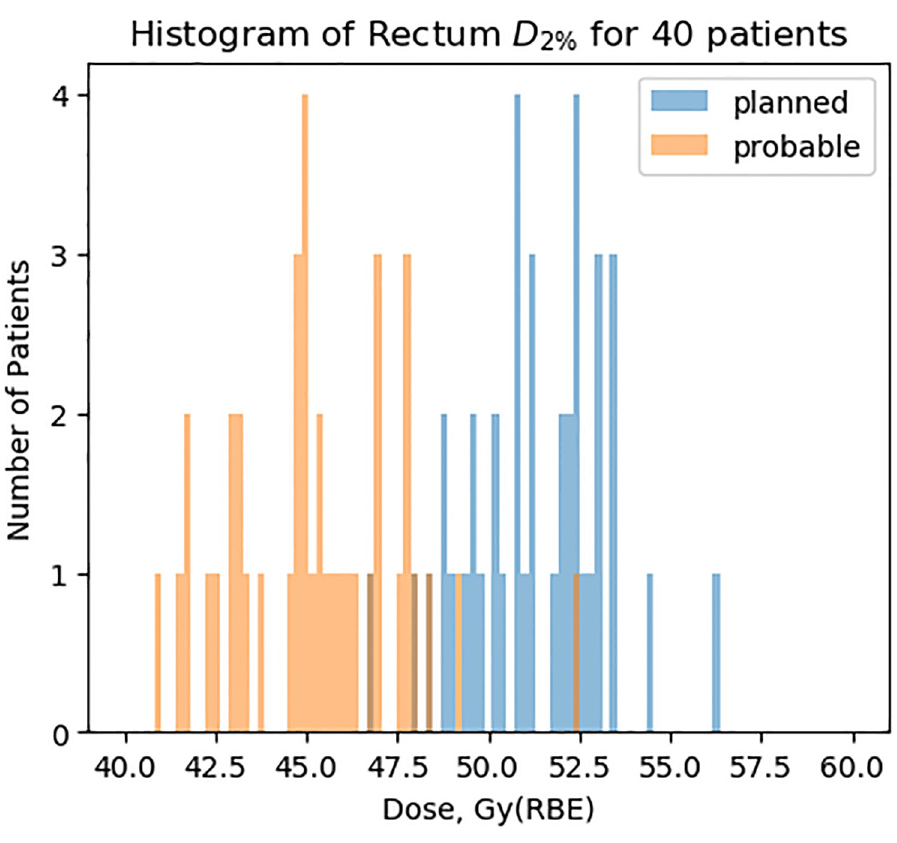
Fig 10. Histograms showing the reduction in D2% resulting from simulated most probable interfractional